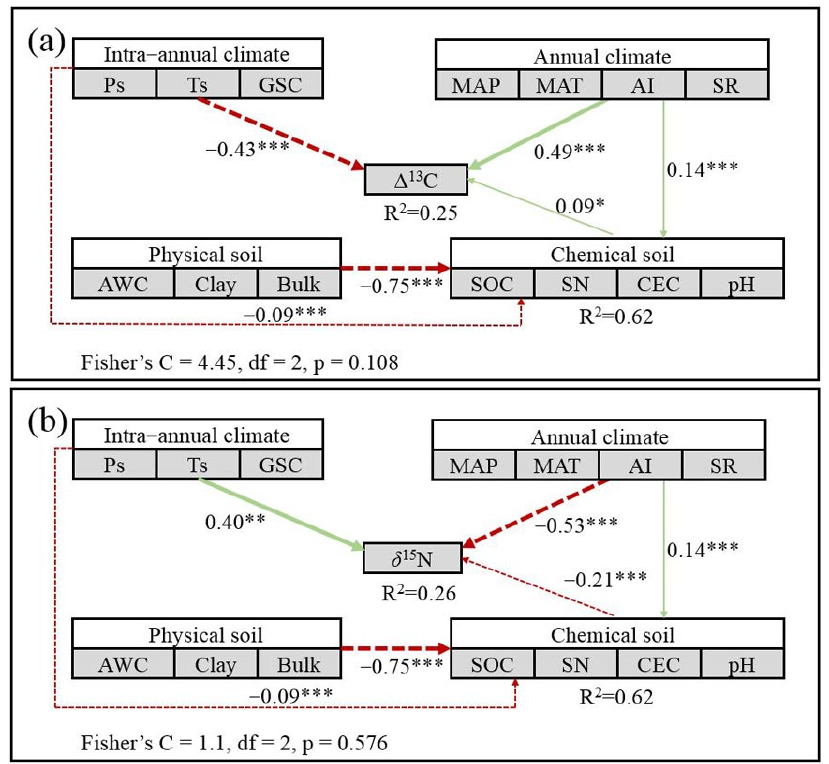
Figure 4. SEM estimation of the driving intensity of foliar Δ 13 C ( a ) and δ 15 N ( b ) signals by soil, climate, and climate seasonality. The first principal component among multiple variables was used to denote the effect of a specific category. Ps, precipitation seasonality; Ts, temperature seasonality; GSC, growth-season climate (the PC2 of monthly climate principal component analysis); MAP, mean annual precipitation; MAT, mean annual temperature; AI, aridity index; SR, solar radiation; AWC, soil available water capacity; Clay, soil clay; Bulk, soil bulk density; SOC, soil organic carbon; SN, soil total nitrogen; CEC, soil cation exchange capacity; pH, soil pH. Significant positive relationships are indicated by green continuous arrows, while negative relationships are indicated by red dashed arrows. The width of the lines is proportional to the significance (*** p < 0.001, ** p < 0.01, and * p < 0.05) (and effect size) of standardized model coefficient estimates. Coefficients of determination (R 2 ) for explained variables are listed below the variable